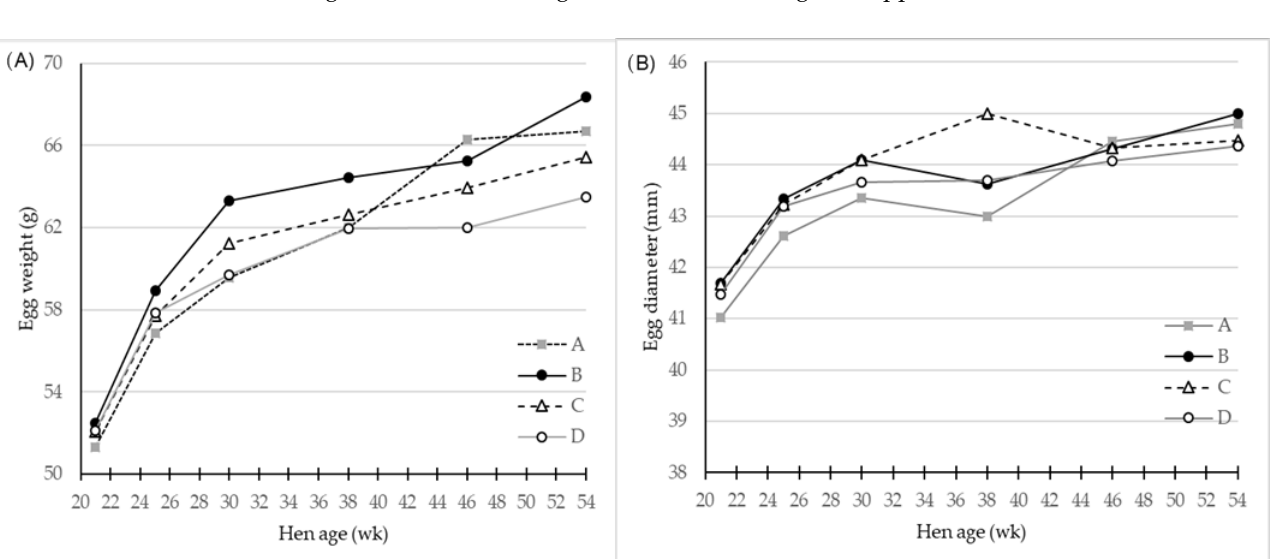
Figure 1. The correct legend and corrected Figure 1 appear below.